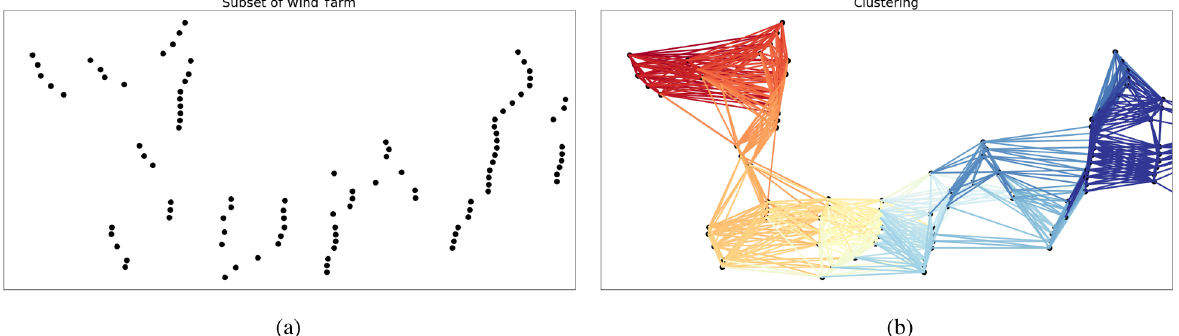
Figure 4. (a) This figure shows a subset of the turbines used in this study. (b) Connecting undirected edges indicating all groupings within the wind farm based on distance from each wind turbine to its